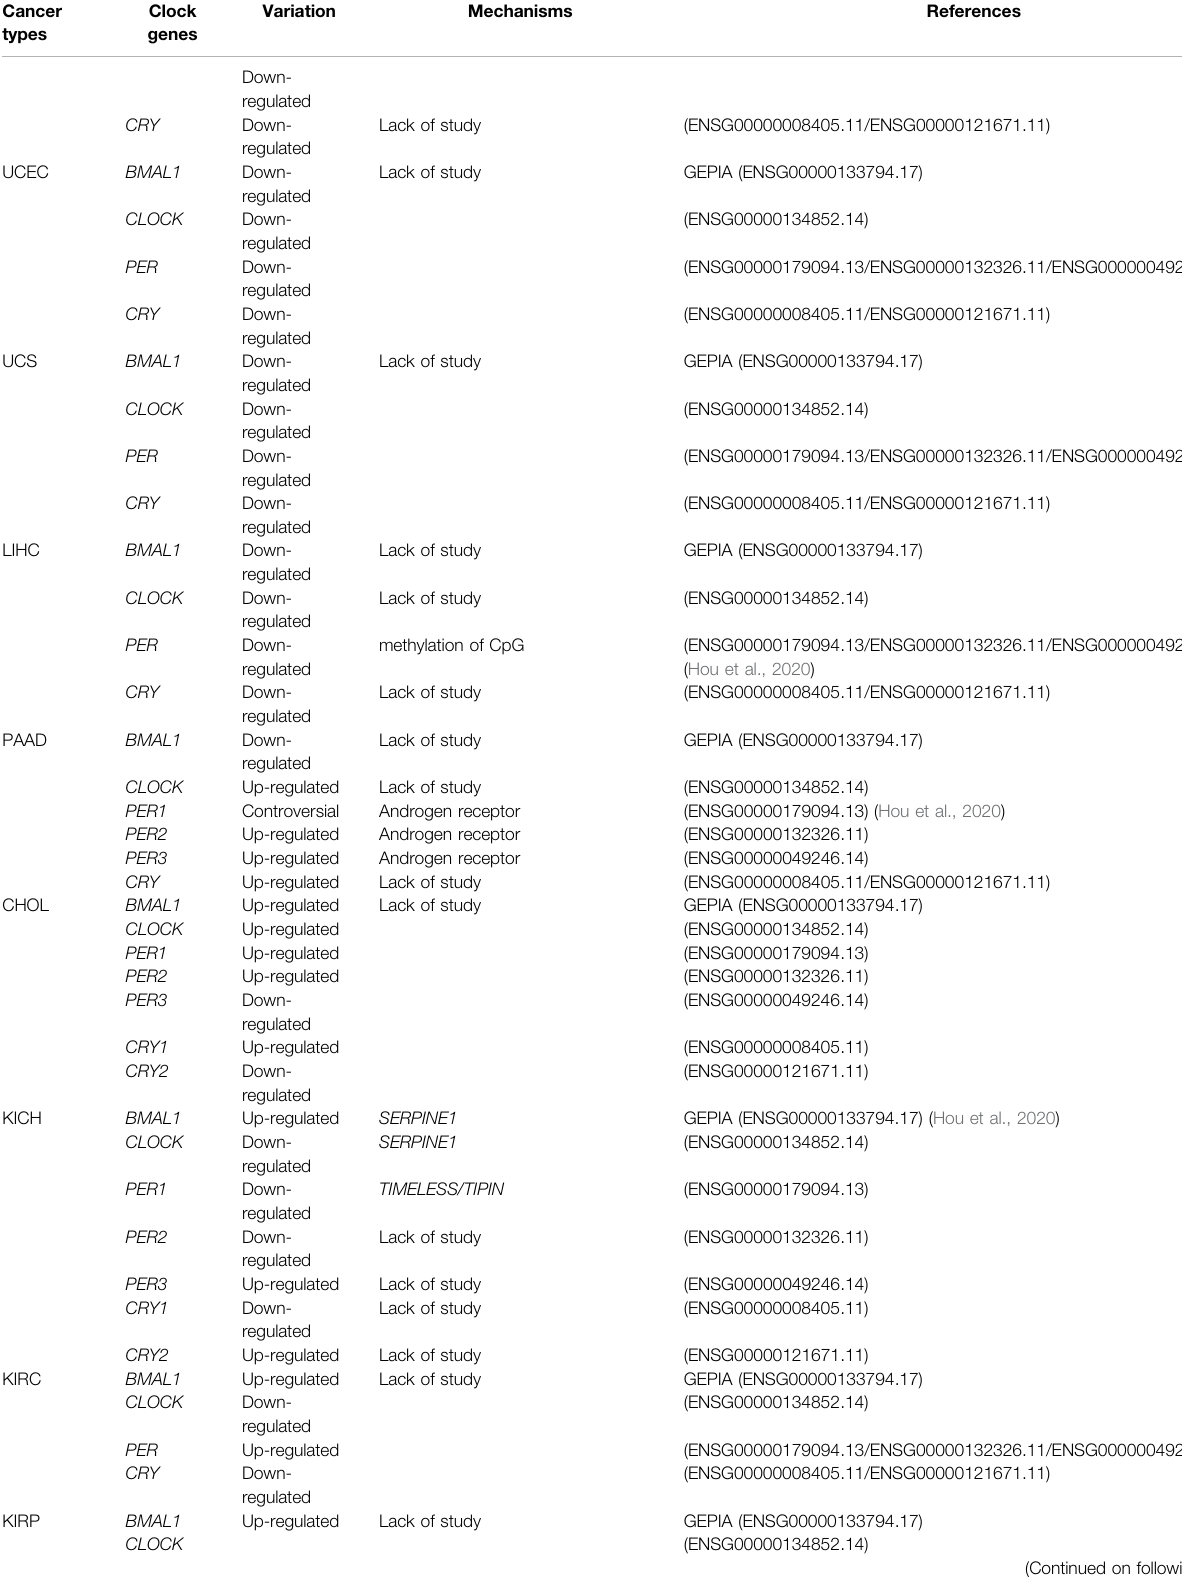
TABLE 1 | ( Continued ) Variational expression of circadian clock genes in different types of